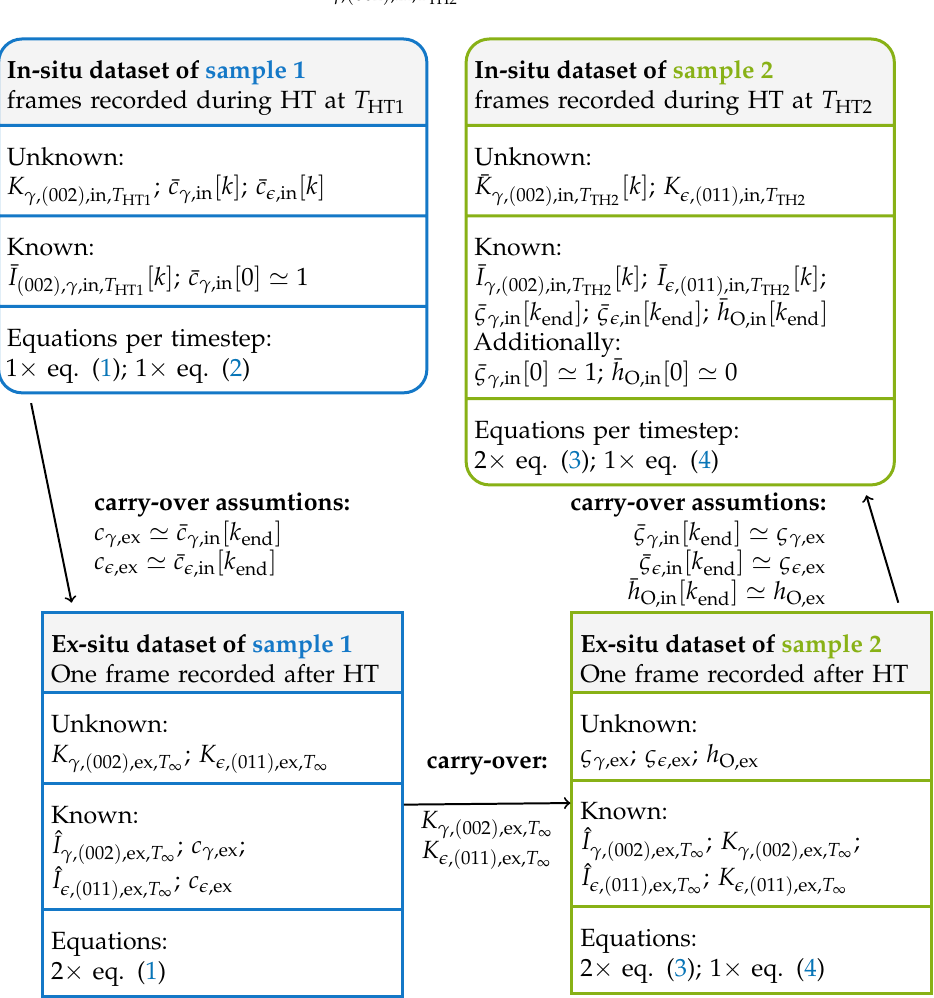
Figure 4. Flow chart for the calculation of calibration constants for all phases present in samples 1 and